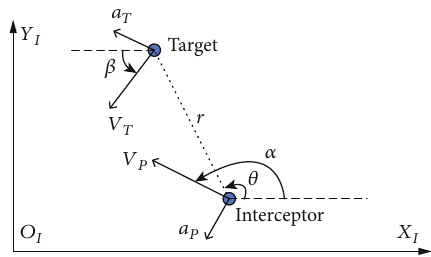
Figure 1: Missile-target engagement